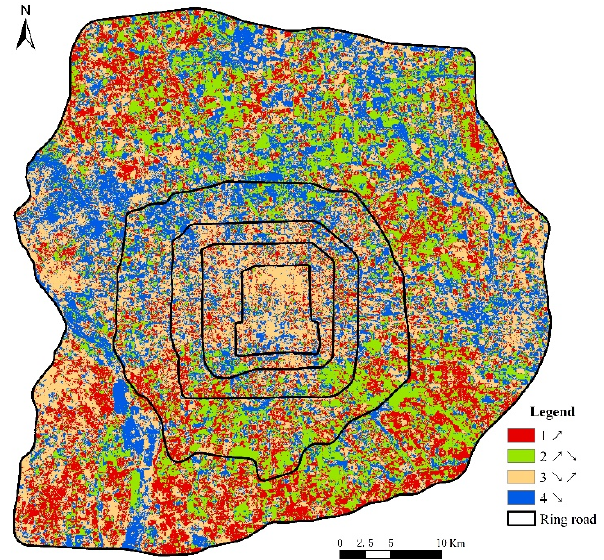
Figure 8. Classification of variation characteristics of sUHI intensity ( ↗ : continuous increase; ↗↘ : first increase and then decrease; ↘↗ : first decrease and then increase; ↘ : continuous decrease).